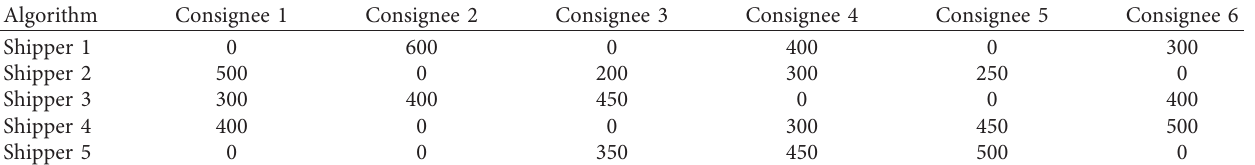
Table 11: Circulation of cargoes at supply and demand points in the large bulk cargo transport network. Algorithm